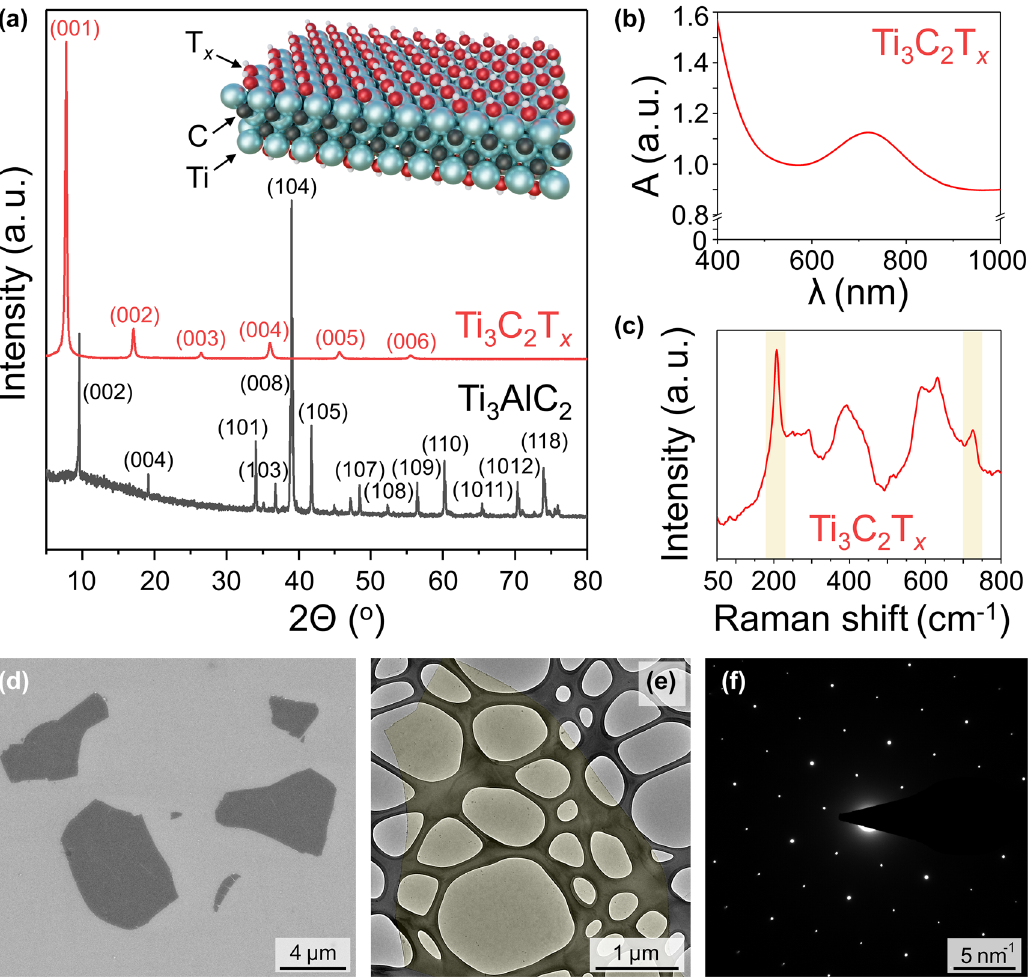
C T flakes. (a) XRD patterns collected for the Ti 3 2 x C T MXene monolayer; Ti – blue spheres, C – black spheres, the surface functional groups (T 3 2 x